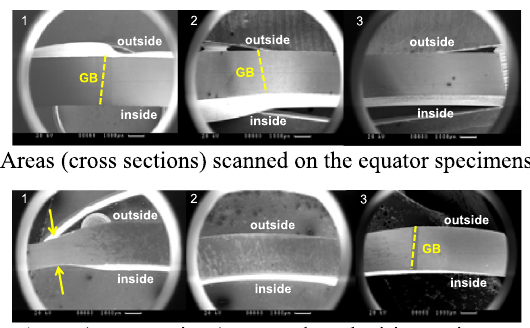
FIG. 3. LAM calculations using the second nearest neighbor sampling area — for the point at the center, average the misor- ientations between all of its neighboring points connected by the short white lines surrounding the kernel [25].